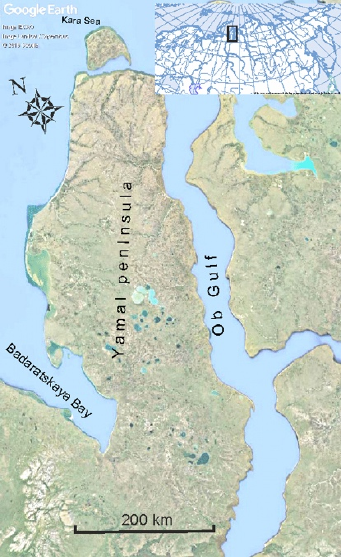
Figure 1. The Yamal peninsula.